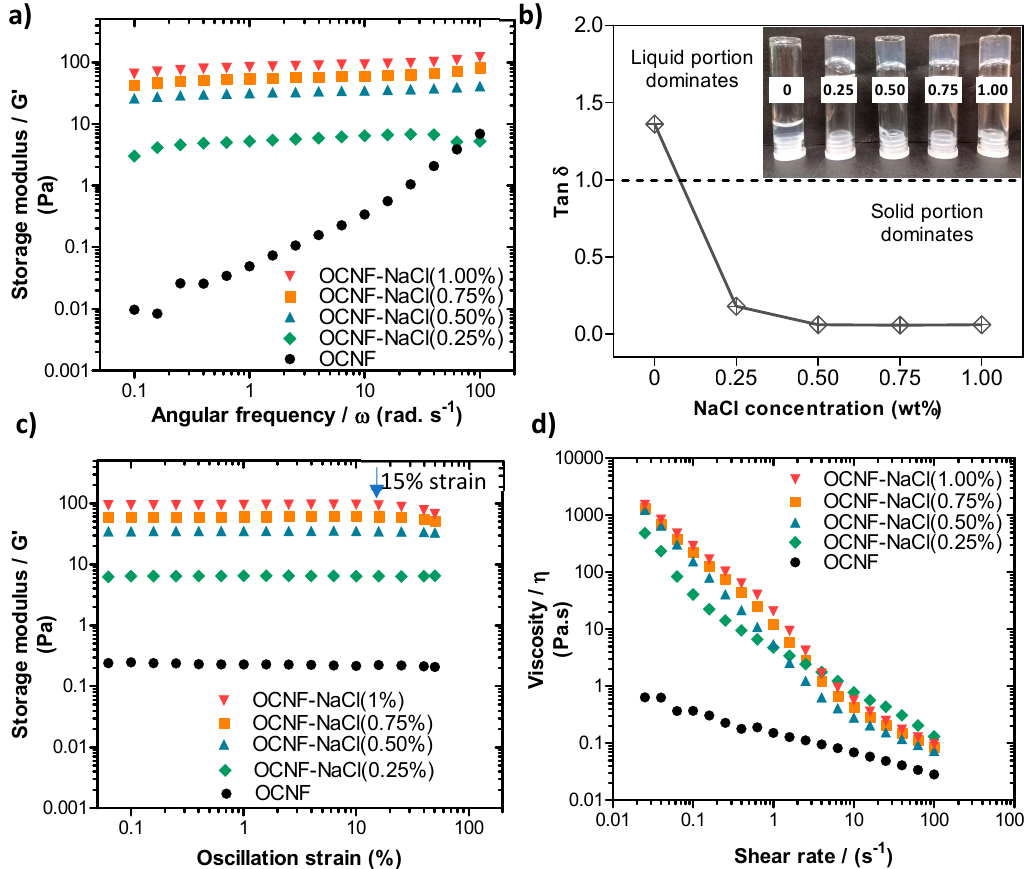
Figure 3. ( a ) Oscillatory frequency sweeps, ( b ) tan δ values obtained at a frequency of 1 Hz (6.28 rad s − 1 ), ( c ) oscillatory amplitude sweeps, and ( d ) shear flow curves of OCNF (1 wt%)/NaCl (0, 0.25, 0.5, 0.75, or 1 wt%) hydrogels. Inset in ( b ) is a photograph of the different samples, labelled by their salt concentration (in wt%). The blue arrow in ( c ) indicates the oscillation strain at which the sample at 1 wt% NaCl deviates from the linear viscoelastic (LVE) regime. Starch suspensions (1 wt%) with various salt contents were also trialled for gel for- mation. In the presence of salt, the starch dispersions were weakly viscous liquids (see Figure S2). The storage modulus of this type of flowing and liquid-like dispersion is diffi- cult to measure in oscillatory mode due to the absence of any entangled gel network. Therefore, the G’ values obtained for various concentrations of starch/salt dispersions (Figure S2) are mostly associated with instrumental noise, and the upturn observed at a higher frequency is an artefact due to inertia. Gelation of starch decreased in the presence of NaCl. This was due to the fact that Na + ions compete with the starch for the bound water in the gel system, resulting in less retrogradation, as suggested in the literature [44–47]. The blended hydrogels were prepared by mixing an OCNF dispersion with a starch suspension at a ratio of 1:1 wt% and various concentrations of NaCl. Their rheological properties are presented in Figure 4. Here, the OCNF:starch (1:1 wt%) gels in the presence